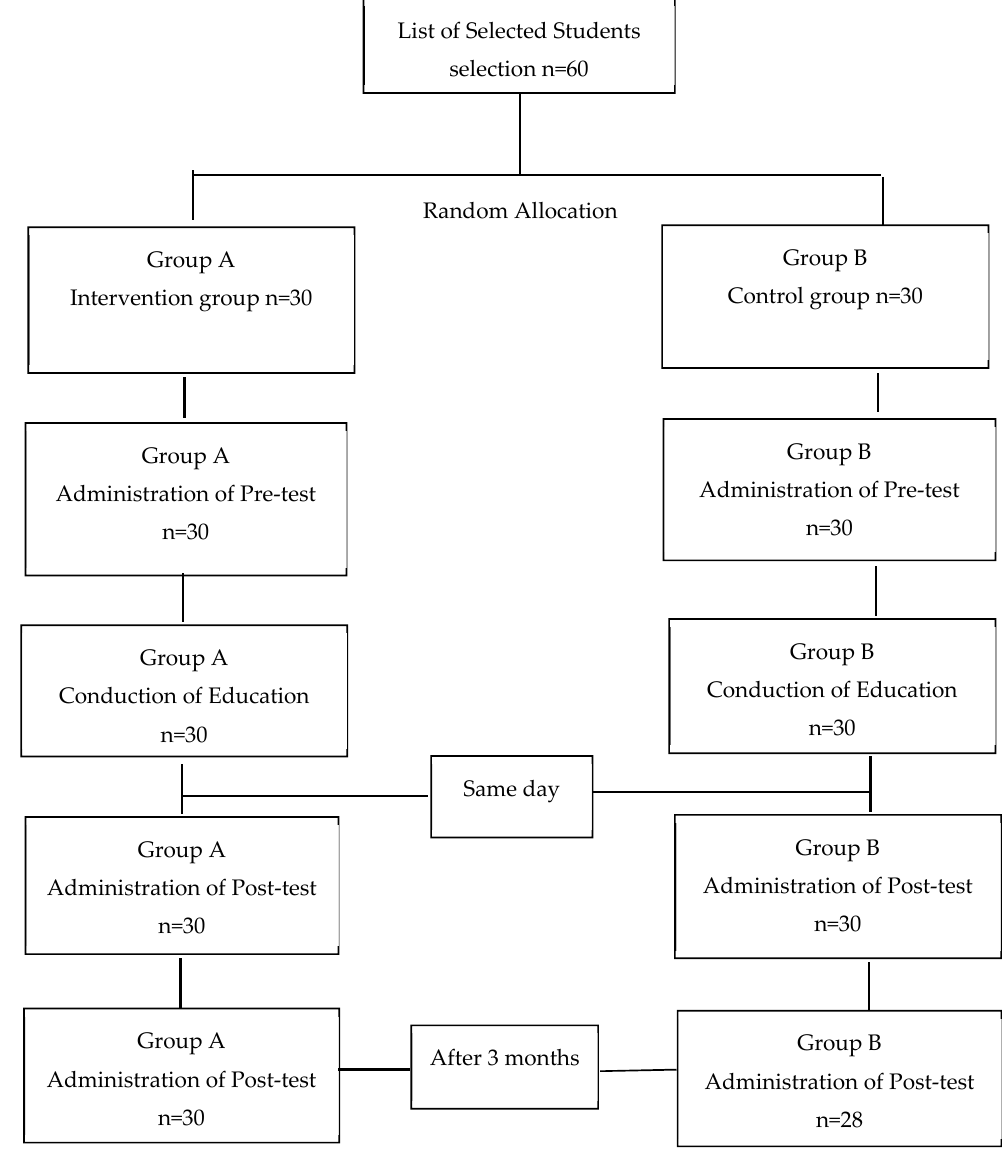
Figure 1. Flow chart of the interventional study.